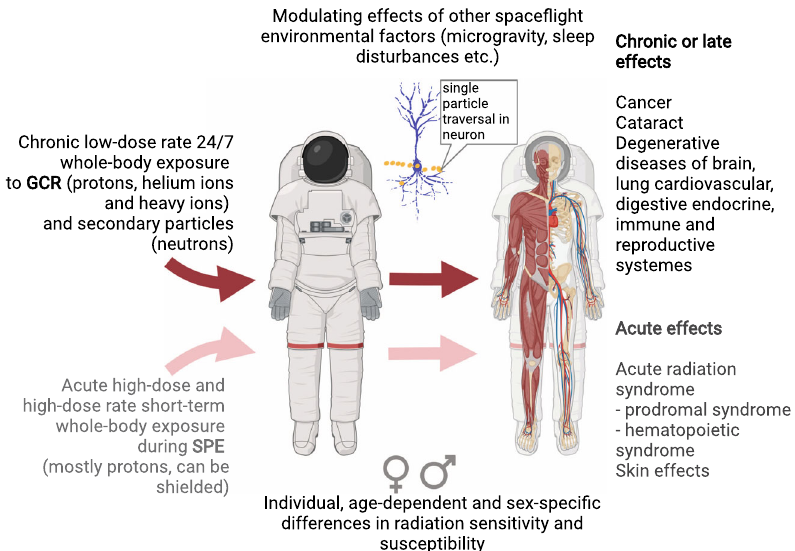
Fig. 2 Radiation exposure during space missions beyond low Earth orbit and health effects of space radiation. Illustration created with BioRender.com for this 2. Exposure of animals (wildtype and genetically altered rodent models, mostly mice) to space-relevant radiation